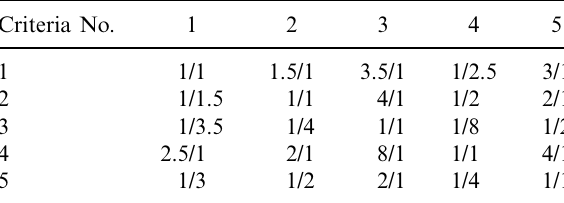
Table 1. Comparison of criteria with respect to goal Criteria